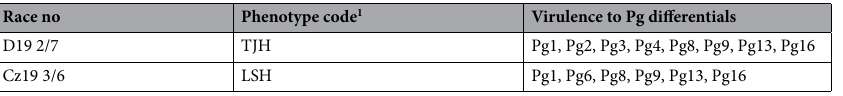
Table 1. Virulence spectrum of P. graminis f. sp. avenae pathotypes used for inoculation. 1 Phenotype code based on the standard differentials set 35